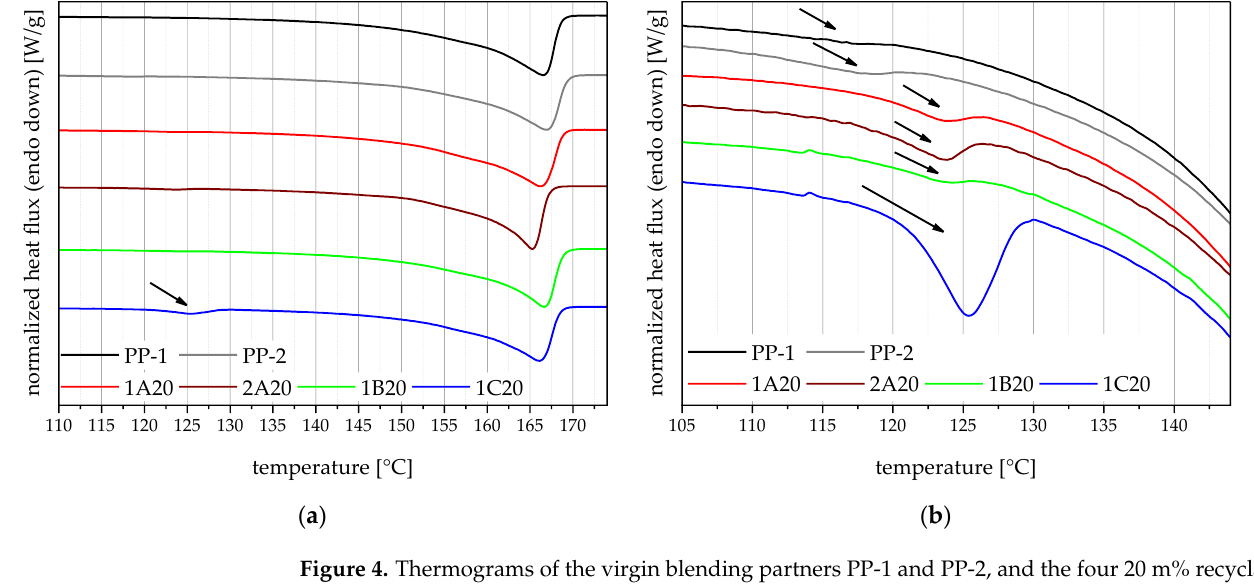
hand, corroborates the density values (as higher melting enthalpy translates to higher crys- tallinity and, therefore, higher density [35]) and furthermore translates into the compounds made with the respective virgin blending partner (see 1A vs. 2A). 1C20 is again easily distinguishable by its significantly lower PP melting enthalpy.